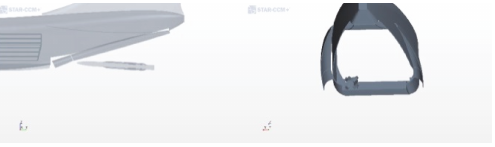
Figure 28: Missile movement posture at 0.6s.